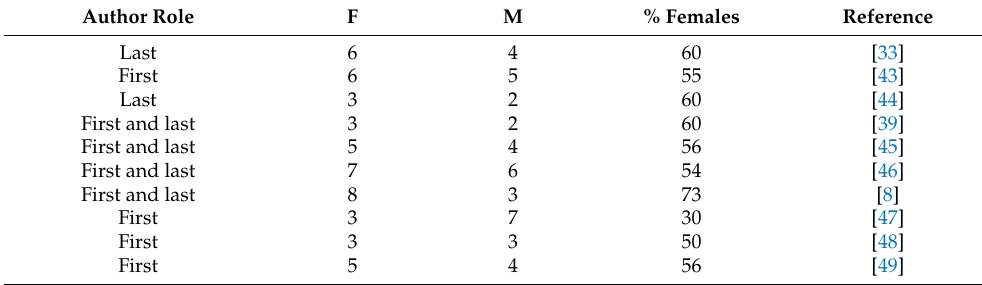
Table 2. Gender ratio among scientists working on the effects of MPs on marine